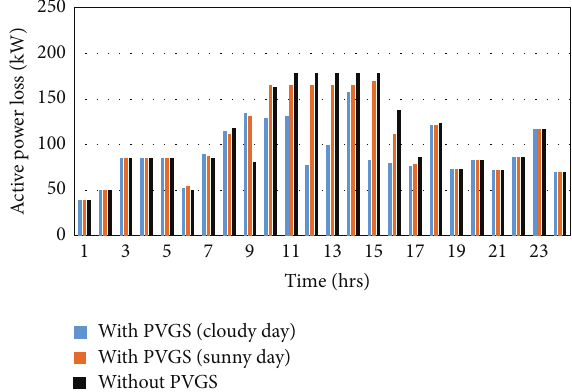
Figure 13: Hourly feeder losses with and without